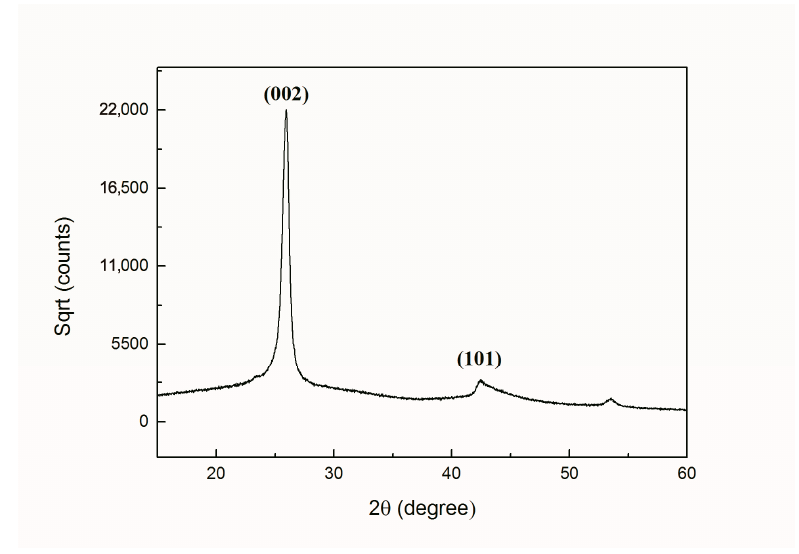
Figure 10. XRD patterns of graphene with multilayers.